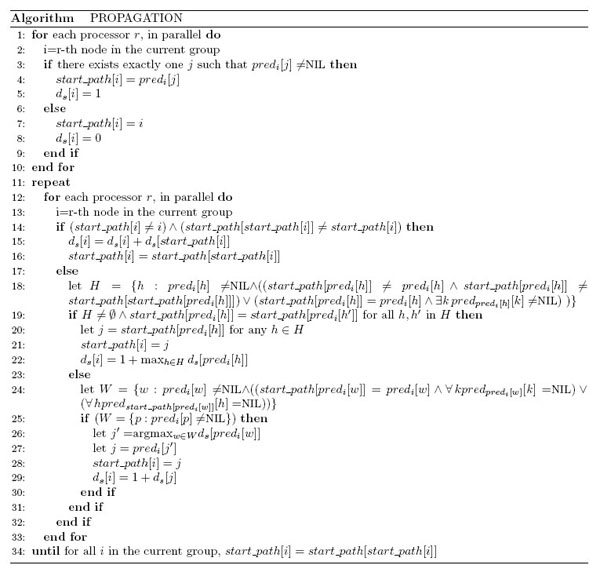
Algorithm of the Propagation procedure. Propagation procedure permits, for each node, to compute the maximum length path passing through it. Pseudo-code is presented for the computation of start_path and ds for any group, while d e and end_path can be obtained by replacing pred and start_path with succ and end_path, respectively.